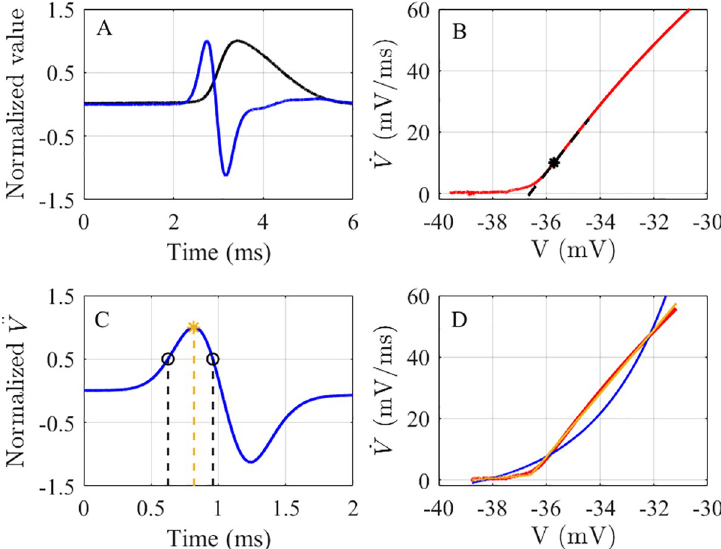
Fig 1. The AP rapidity quantification methods. A) A normalized AP from a mouse RS somatosensory cortical . B) The initial portion of the phase plot of the same AP in A. The black asterisk neuron (black), and its normalized € V m indicates the criterion level (10 mV/ms), and the dashed black line represents the phase slope. C) The normalized € V : m : reaches half its of the same AP in A on a smaller time scale. The black circle indicates the points at which € V m maximum value before and after peaking, while the yellow asterisk represents the maximum normalized € V : value. m The time between the black dashed lines is the FWHM, and the time between the first black dashed line and the yellow dashed line is the HWHM. The IFWd 2 and IHWd 2 are defined as the reciprocal of the FWHM and HWHM, respectively. D) The red line shows the selected portion of the phase plot in A. The blue line shows the exponential fit, and the yellow line shows the piecewise linear fit of the selected portion of the phase plot. The error ratio is calculated as the ratio of errors of exponential fit to the piecewise-linear